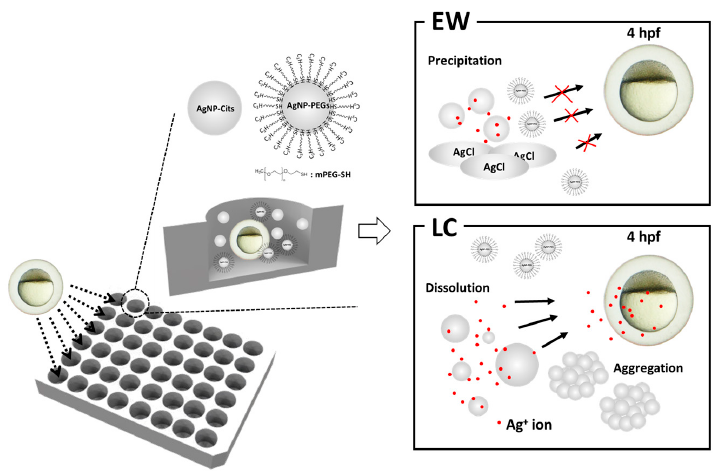
Figure 1. Schematic illustration of citrate ‐ stabilized AgNPs (AgNPs ‐ Cit) and polyethylene glycol ‐ coated AgNPs (AgNPs ‐ PEG) toxicity evaluations in different ionic environments.